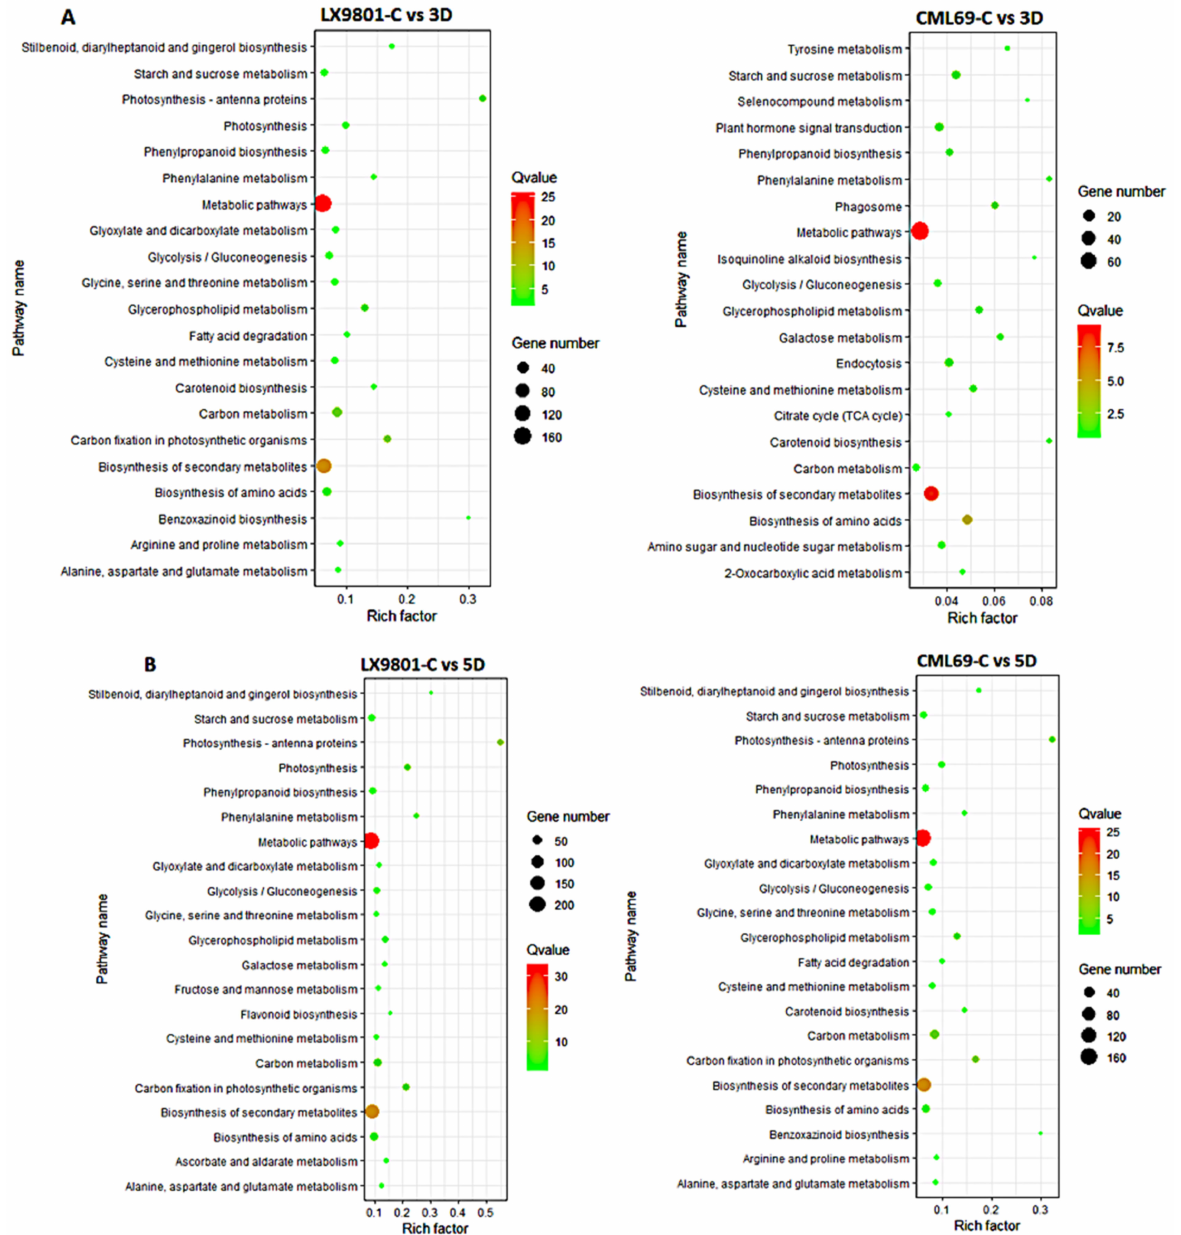
Figure 4. KEGG pathway enrichment analysis of the common drought-responsive genes. ( A ) DEGs expressed at 3D drought stress. ( B ) DEGs expressed at 5D drought stress. The experimental comparisons were based on the hypergeometric test, while the significance of the enrichment of the KEGG pathway is based on the q value (q < 0.05). The “rich factor” shows the DEGs’ ratio to the total gene number in specific pathways. Drought treatments are labeled as control (C), three days (3D), and five days